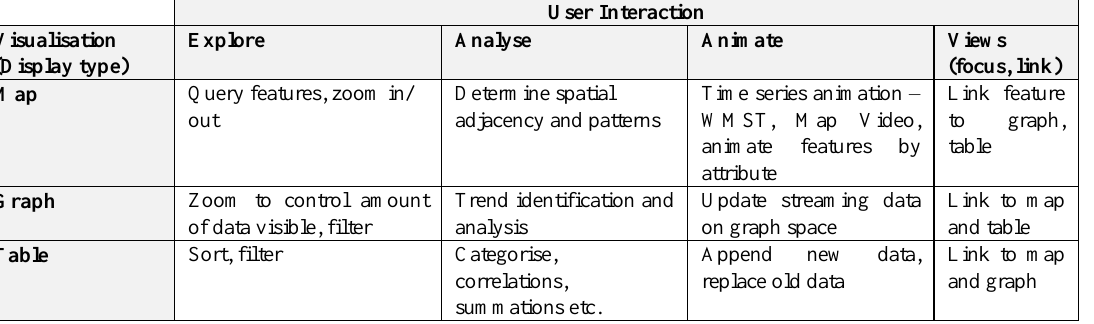
Table 3. Example of relationship between visual representation and expected user